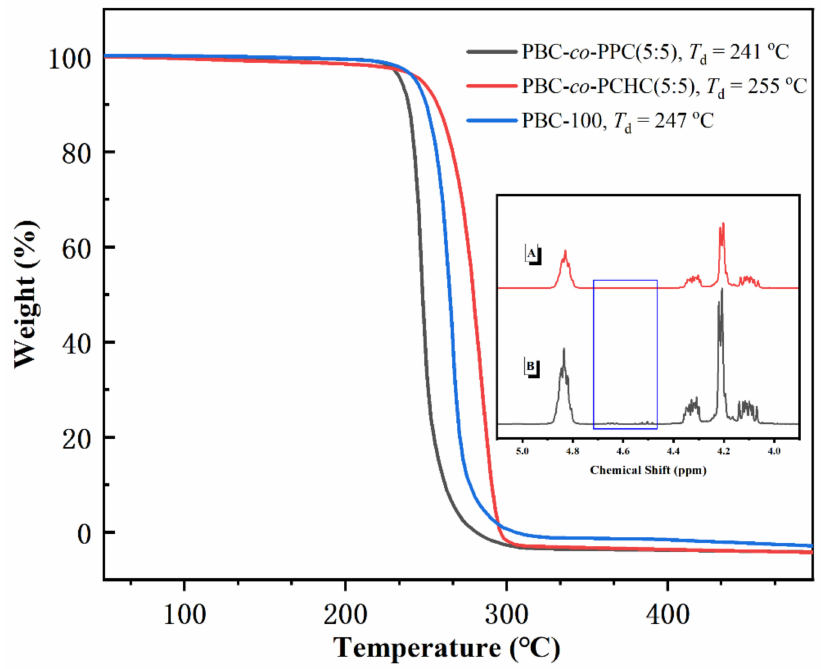
Figure 4. TGA curves of the obtained polycarbonates and 1 H NMR of pure PBC ( A ) after heating for 10 min ( B